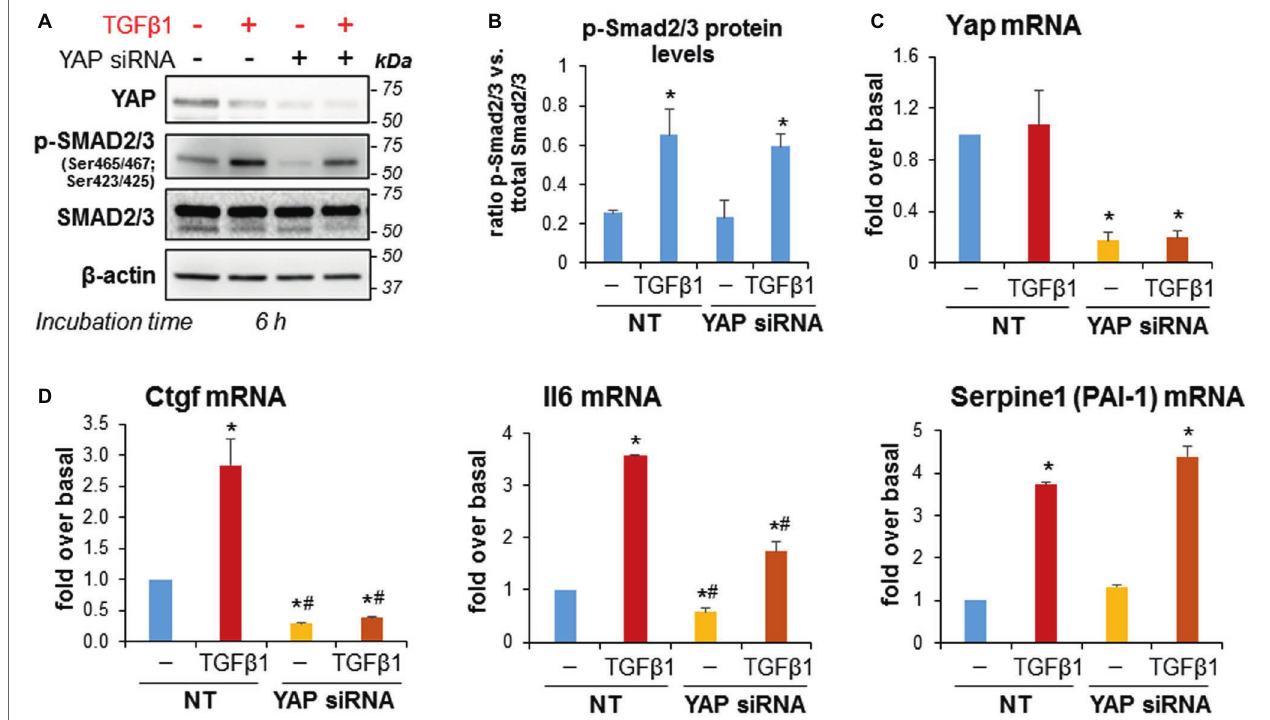
FIGURE 8 | YAP siRNA significantly reduced TGF β 1-induced upregulation of Ctgf and IL-6 in imPaSC. (A) Twenty-four hours after transfection, mock and YAP- transfected imPaSC were treated with 5 ng/ml TGF β 1 for 6 h. As shown in the immunoblots, TGF β 1-induced activation of the SMAD2/3 pathway was similar in mock and YAP siRNA-treated cells. Similar results were obtained in three independent experiments. (B) Graph shows optical density (OD) of the immunoblots depicted in panel A determined by densitometry. (C,D) Twenty-four hours after transfection, mock (NT) and YAP-transfected imPaSC were treated with 5 ng/ml TGF β 1 for 6 h. mRNA levels of Yap (C) , Ccn1 (Ctgf), Il6, and the TGF β 1 target gene Serpine 1 (PAI-1) (D) were measured by qPCR and quantified relative to those of 18S rRNA. Data in graphs in panels B–D represent means ± SEM from three to five independent experiments; * p < 0.05 vs. NT-not treated ( − ); # p < 0.05 vs. NT-TGF β